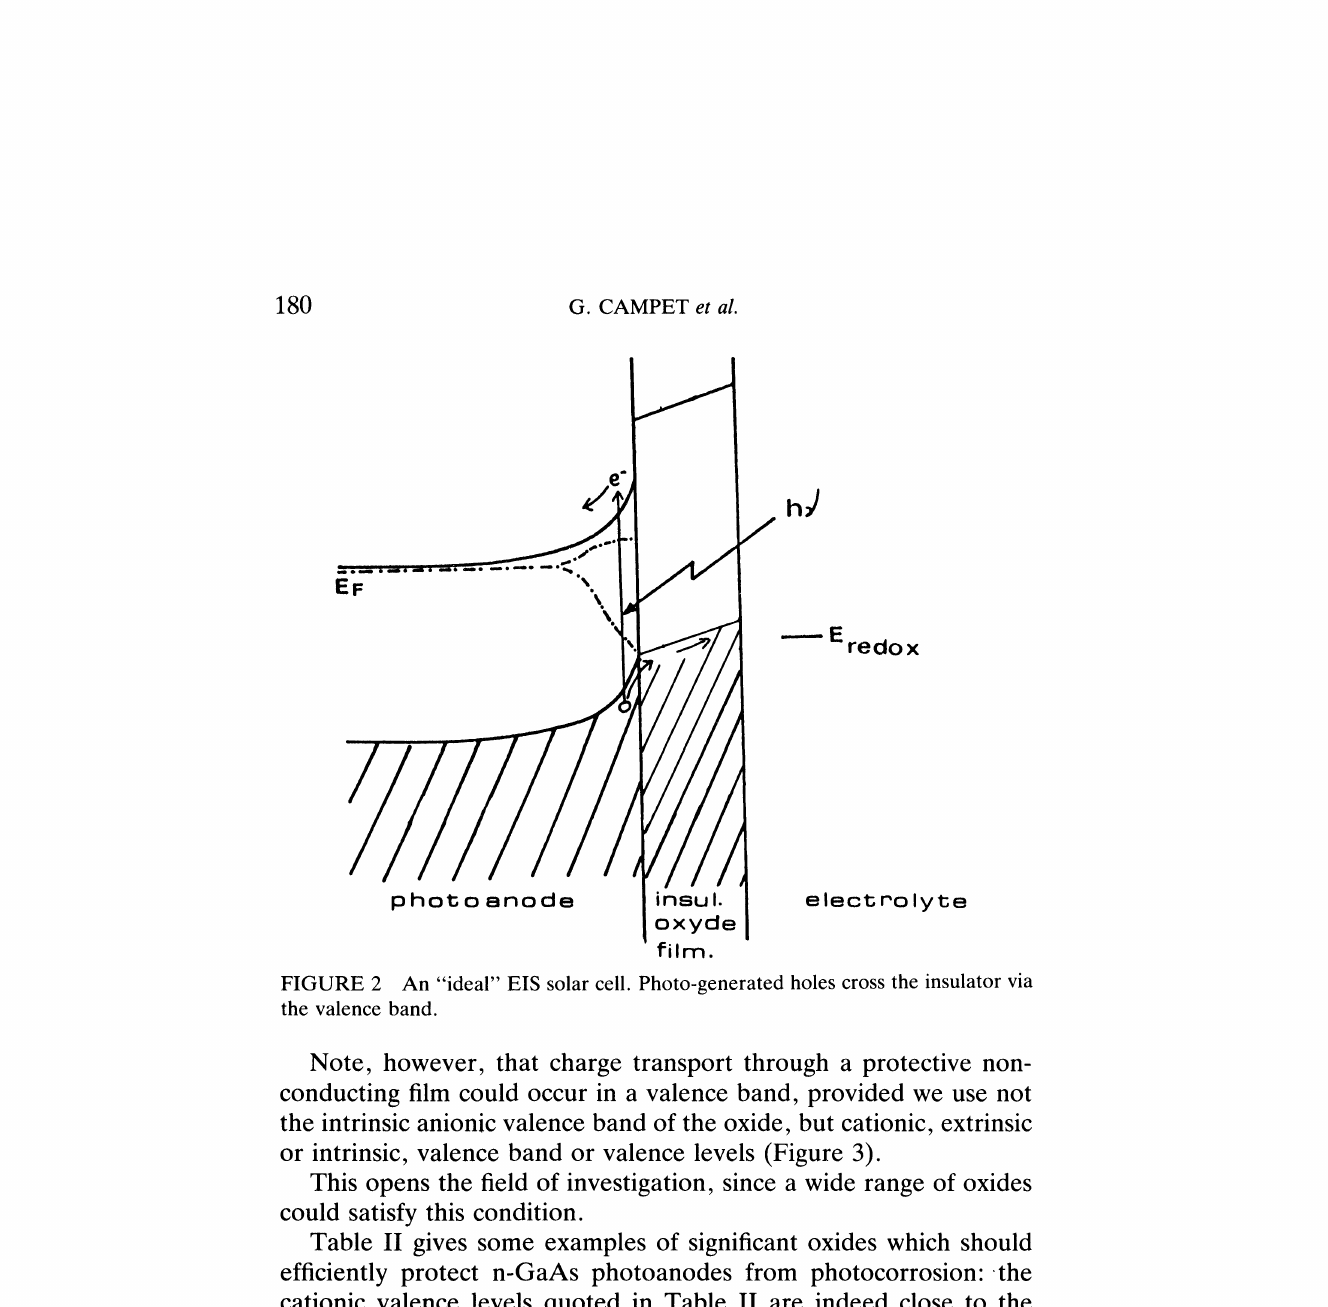
FIGURE 2 An "ideal" EIS solar cell. Photo-generated holes cross the insulator via the valence